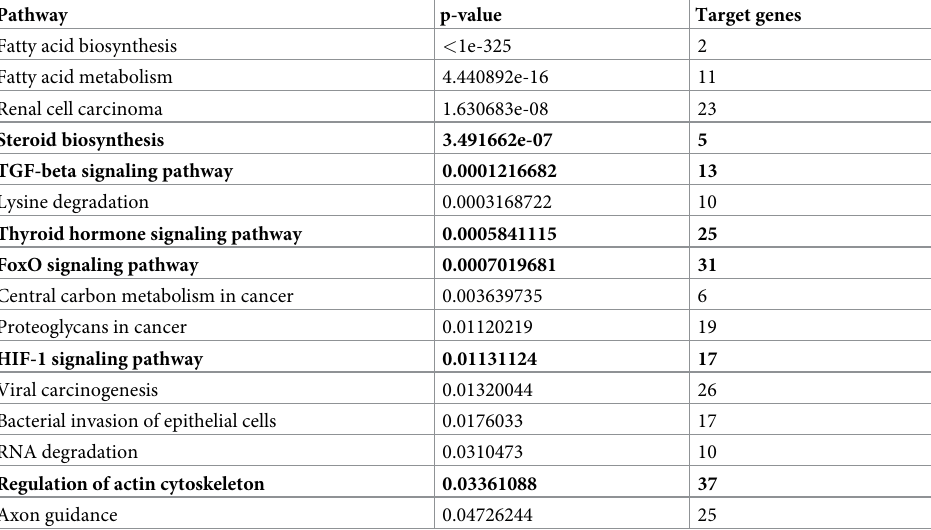
Table 4. Statistically significant union pathways refer to the miRNAs with an increased expression on day 5.